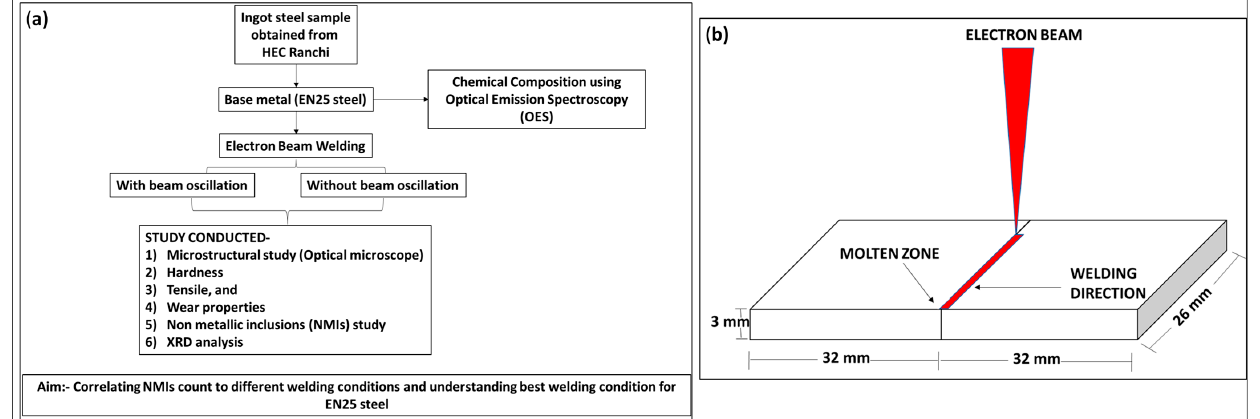
Figure 1. Workflow of the present study, ( a ) methodology and ( b ) electron beam welding on EN25 base material, with/without beam oscillation. Table 2. Parameter of electron beam welding with full penetration at 3 mm depth for all welding conditions.